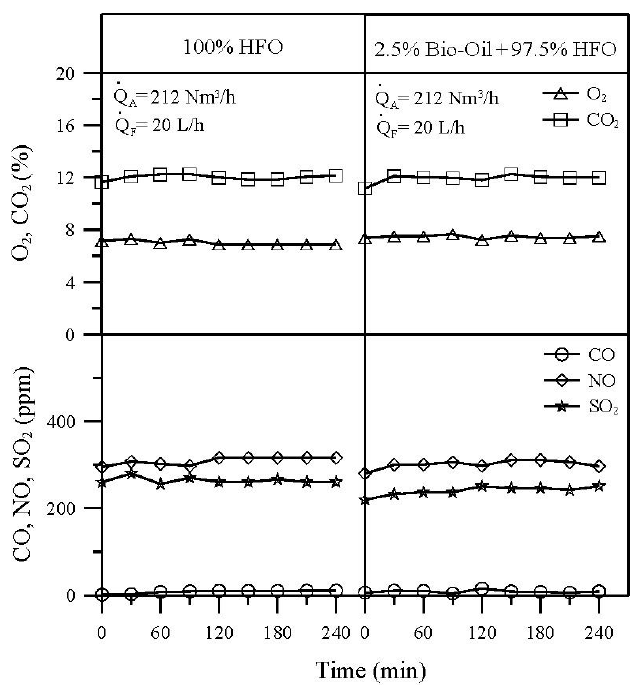
Figure 6. Emissions when burning 100% HFO and the emulsion of 2.5% bio ‐ oil and 97.5% HFO.